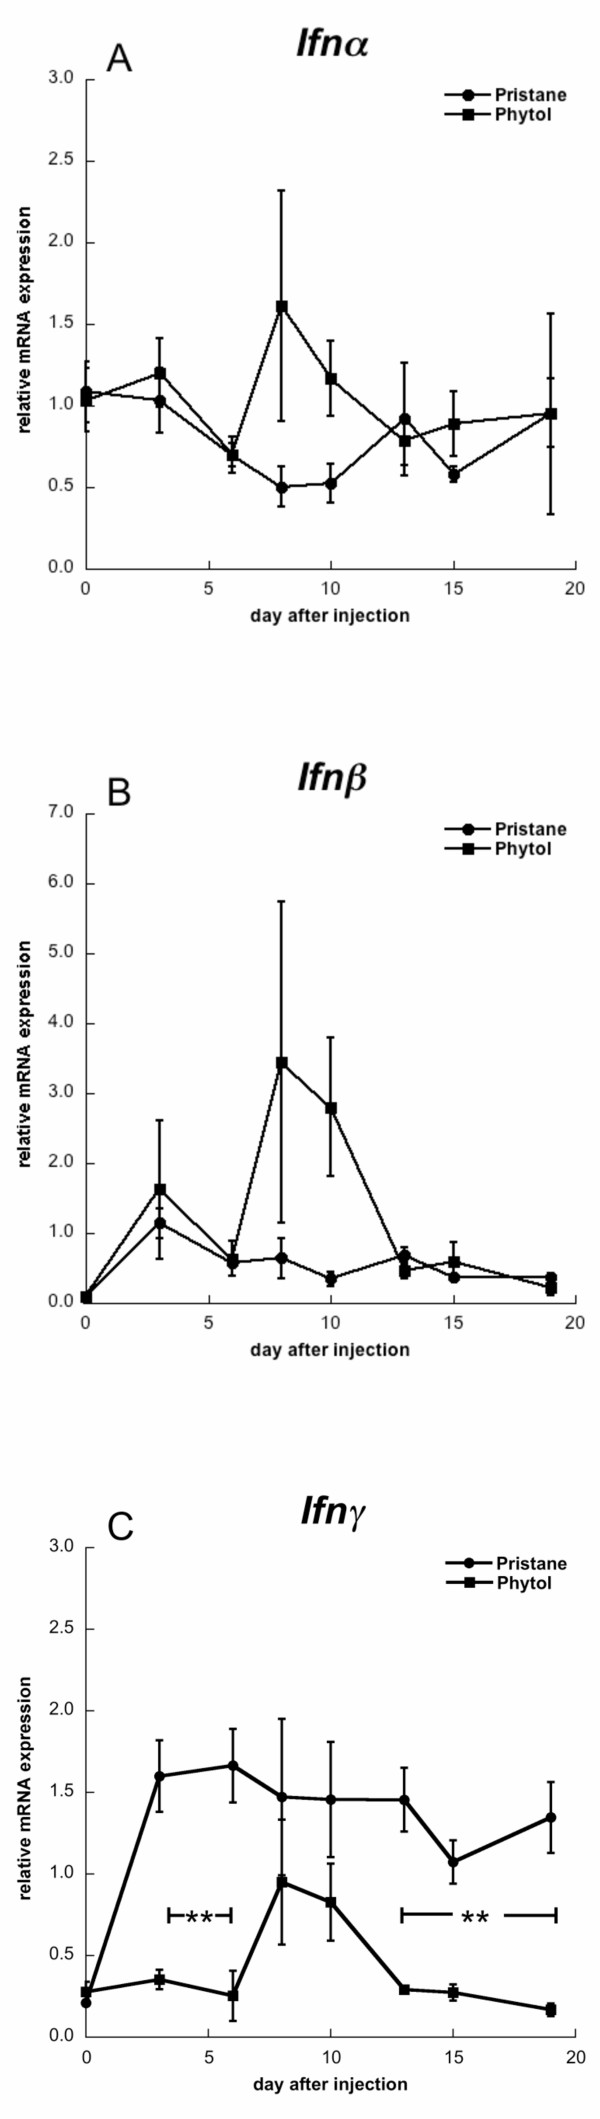
The relative mRNA expression of (A) Ifnα, (B) Ifnβ and (C) Ifnγ in lymph nodes at 0, 3, 6, 8, 10, 13, 15 and 19 days after injection with pristane (circles) or phytol (squares). Values are means ± SEM from groups of four animals. Levels of significance were calculated using Student's t-test (**p < 0.01).